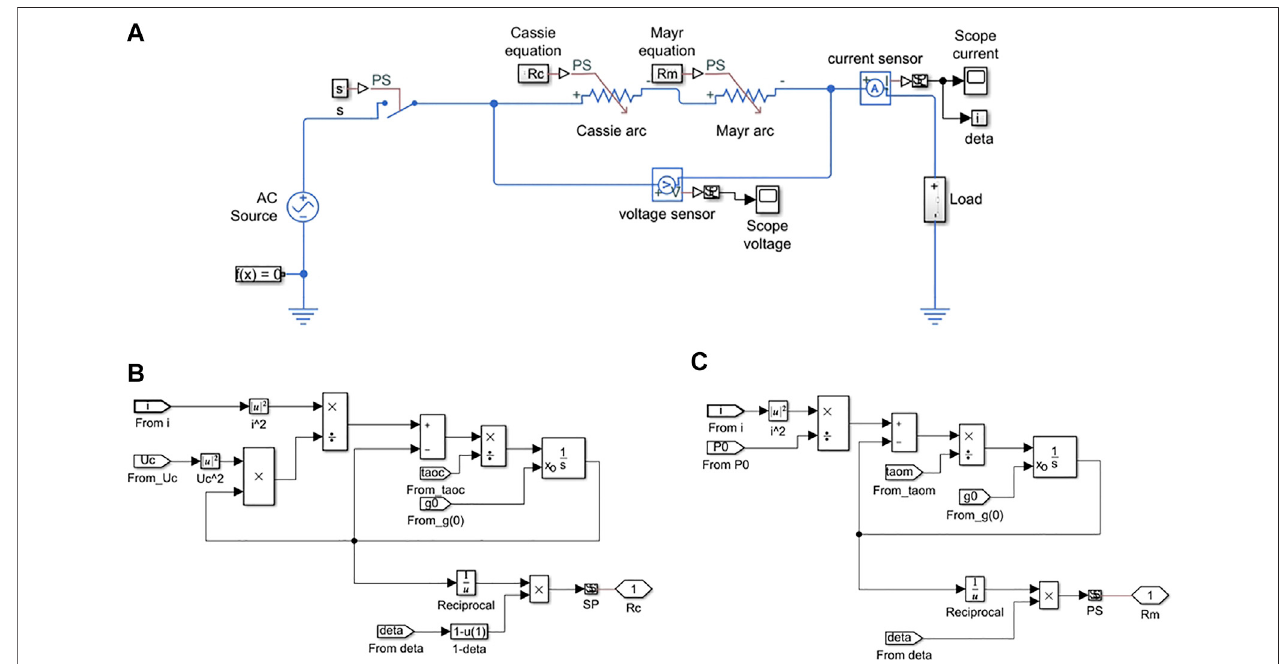
FIGURE 1 | Cassie-Mayr Simulink model: (A) circuit model, (B) Cassie equation module, and (C) Mayr equation module.